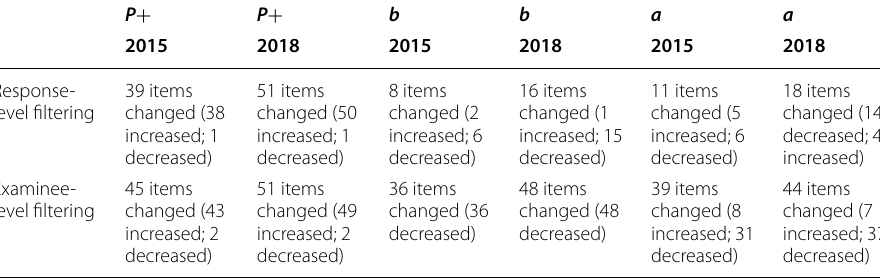
Table 1. Summary of changes of item parameters